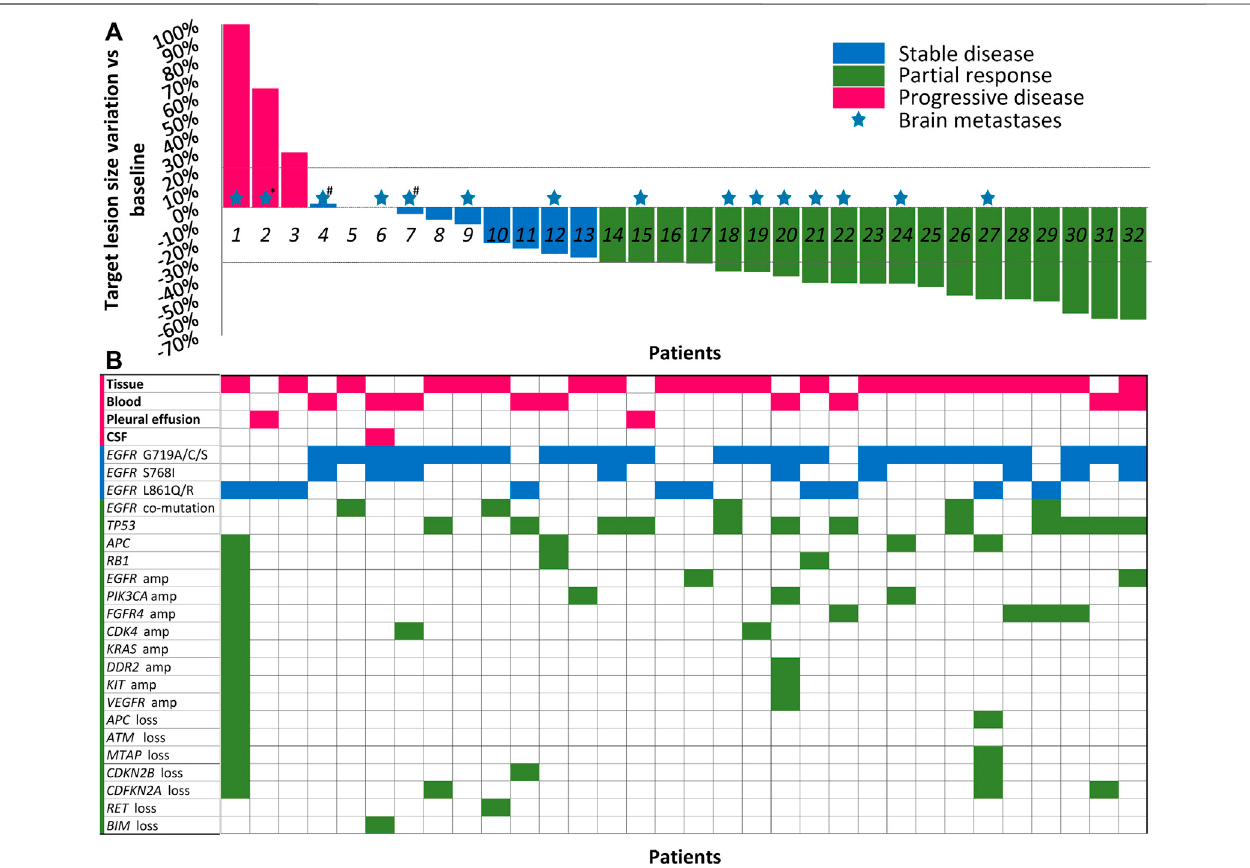
FIGURE1| Bestshrinkageoftargetlesionsizeandcorrespondingmutationpro fi lebypatient( N =32). (A) Treatmentresponsesofdacomitinibinall32patientsare shown in the waterfall plot. Patients with compound mutations and brain metastases were marked with colored pentagrams. *Brain metastases not evaluated due to patient ’ s poor condition. #The patients also received whole brain radiotherapy before dacomitinib initiation. Dashed lines represent 20% progression (progressive disease) and 30% tumor regression (partial response). (B) The corresponding mutation pro fi le of each patient was displayed under the waterfall plot. CSF, cerebrospinal fl uid; amp, ampli fi